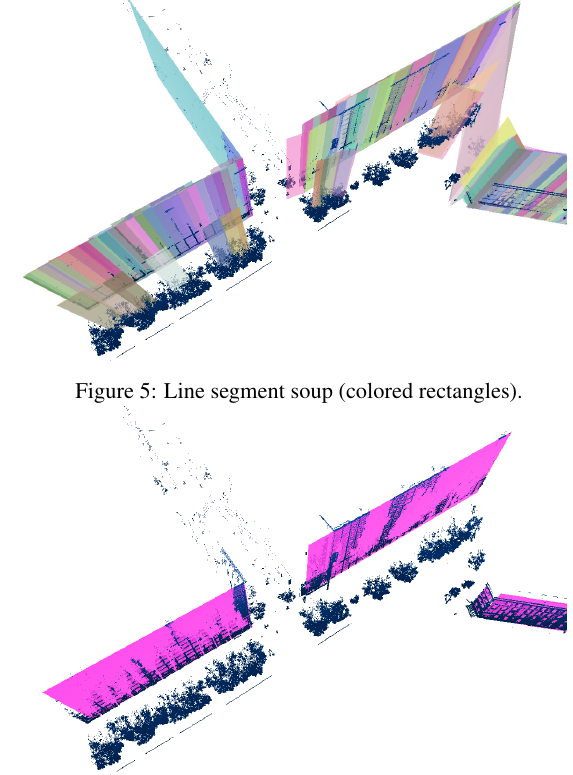
Figure 6: Output : detected rectangles (pink).